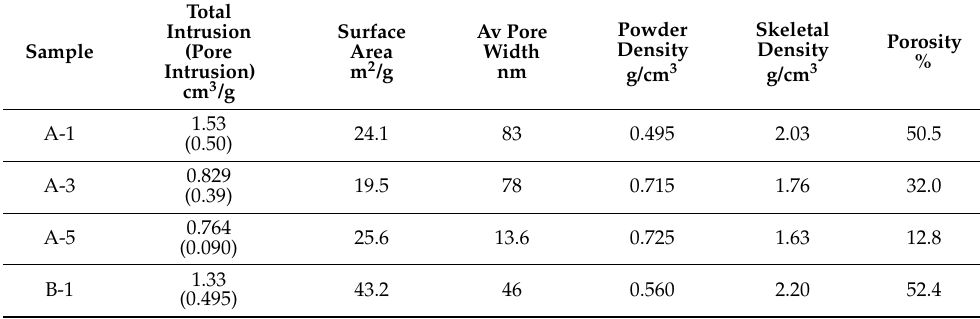
Table 5. Characteristic of the microsphere’s porosity by mercury